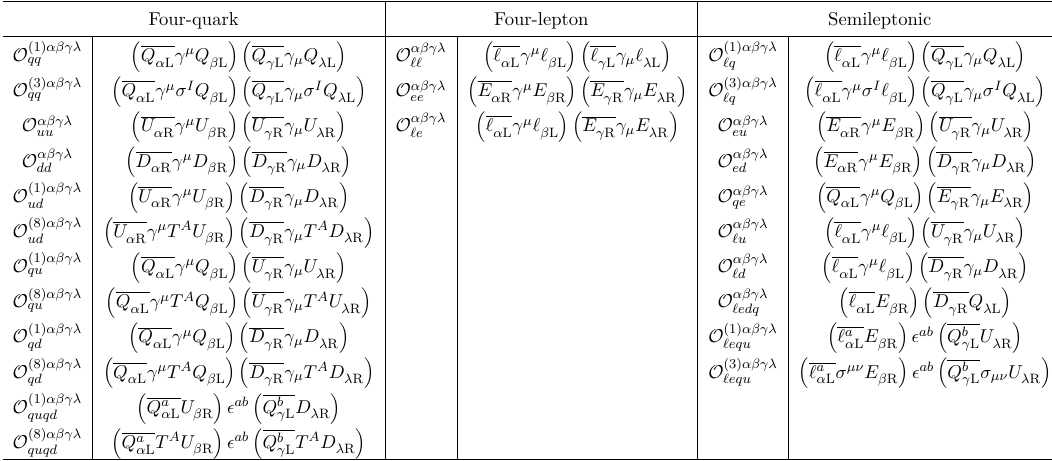
Table 4 . Baryon and lepton number conserving four-fermion operators in the Green’s basis (and also in the Warsaw basis) in the SMEFT.